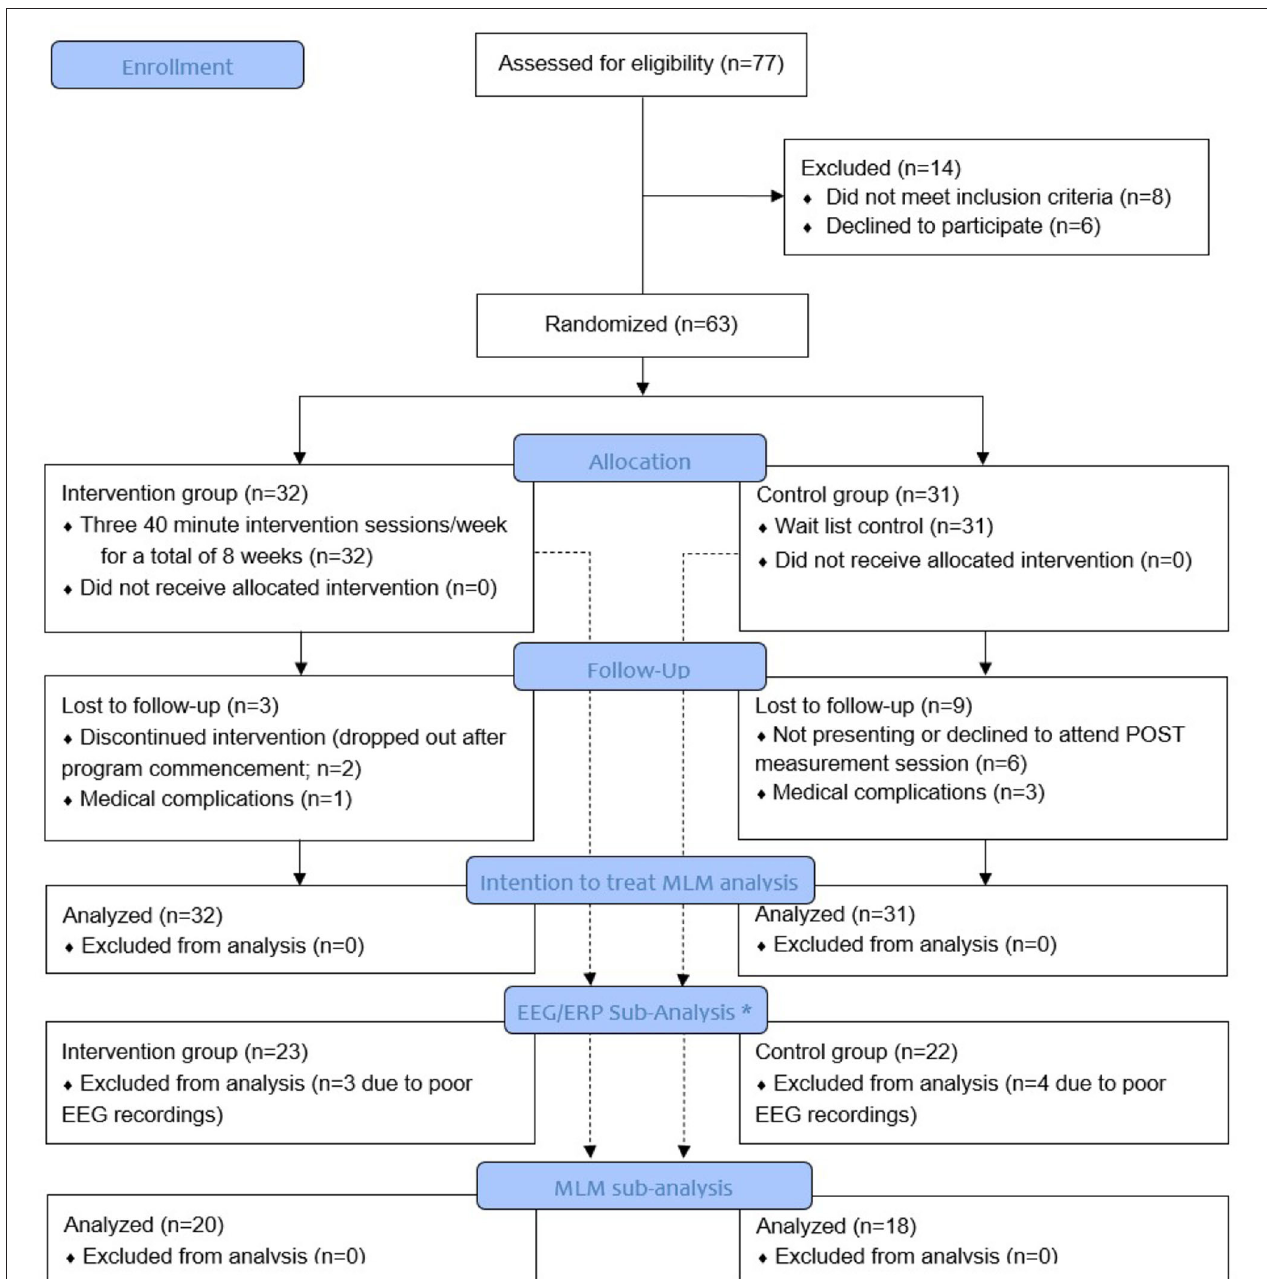
FIGURE 1 | Study flow diagram. *A mixed linear model (MLM) analysis of variance was used for EEG sub-analysis when EEG data were of good quality and a merged pre-post EEG decomposition was acceptable. Poor quality of pre- or post-EEG data resulted in elimination of both datasets.